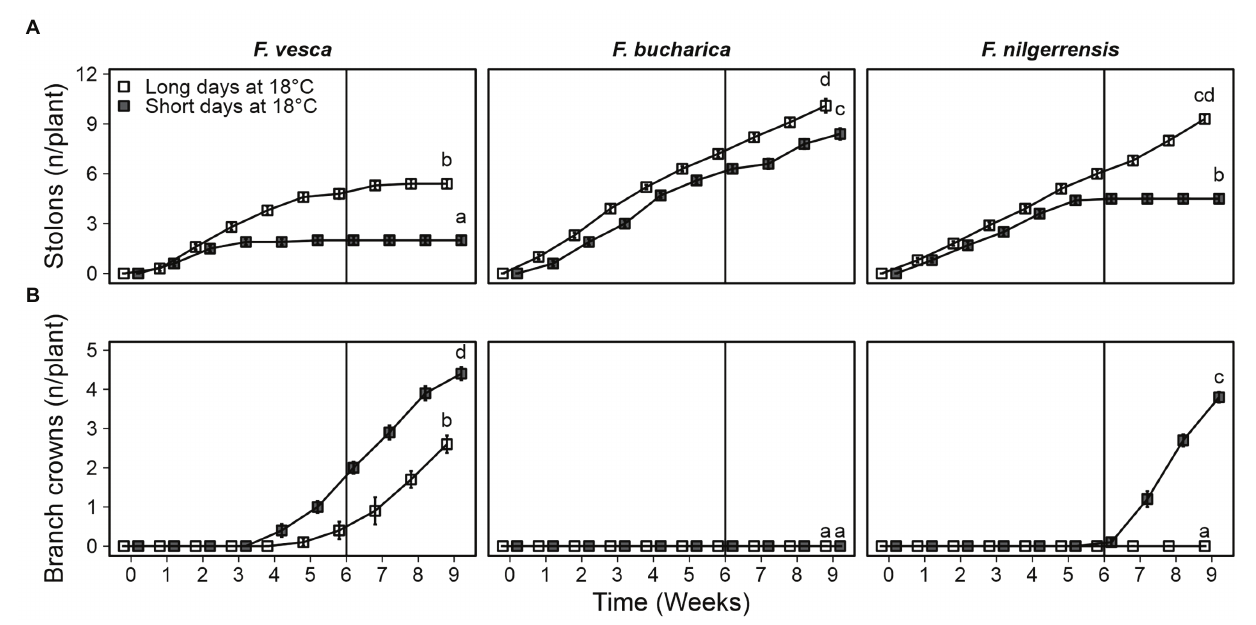
FIGURE 3 | Axillary bud fate of three diploid strawberry species grown in SDs or LDs at 18 ° C. Number of stolons (A) and branch crowns (B) per plant. Stolon- propagated plants were grown in LDs (18-h) or SDs (12-h) at 18 ° C for 6 weeks followed by LDs (18-h) at 18 ° C. Number of stolons and branch crowns was recorded weekly until week 9. Error bars represent the SEM ( n = 10) and different letters indicate significant differences calculated by ANOVA and Tukey’s test ( p <